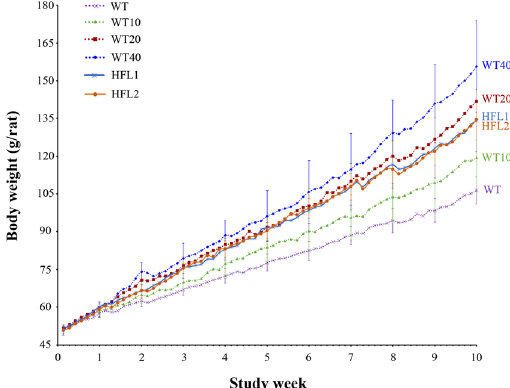
Figure 2. Body weight changes in rats fed different diets for 70 d.